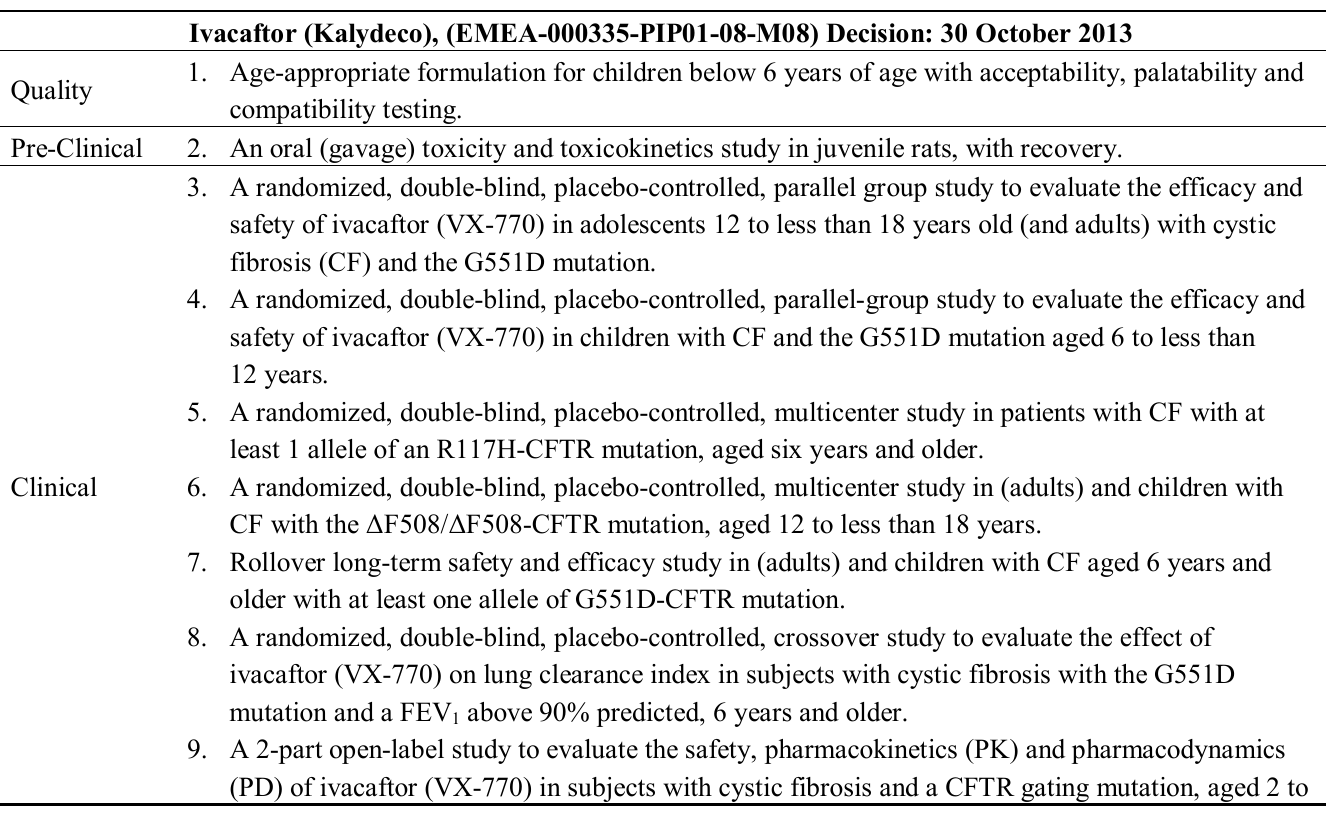
Table 2. PIP measures for ivacaftor